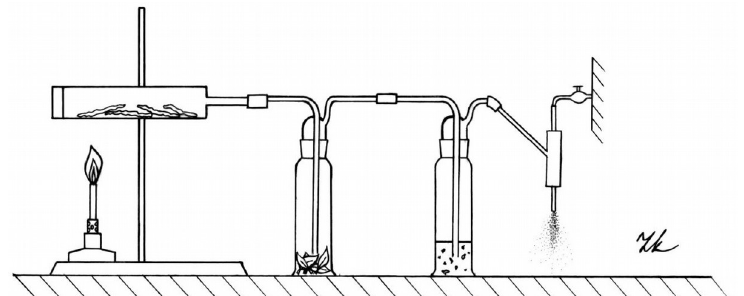
Figure 2. Apparatus schematic (Kričková,